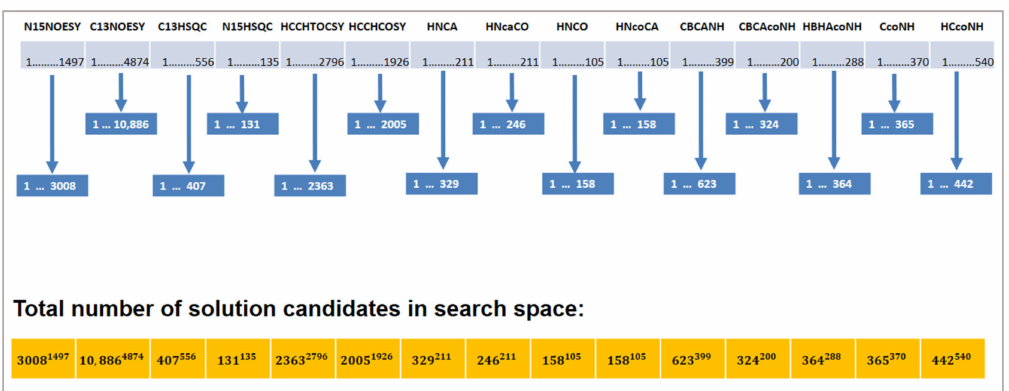
Figure 5. Assignment on several spectra. The upper part shows the number of the expected peaks and measured peaks for each spectrum. The lower part below shows the total number of solution candidates for the whole